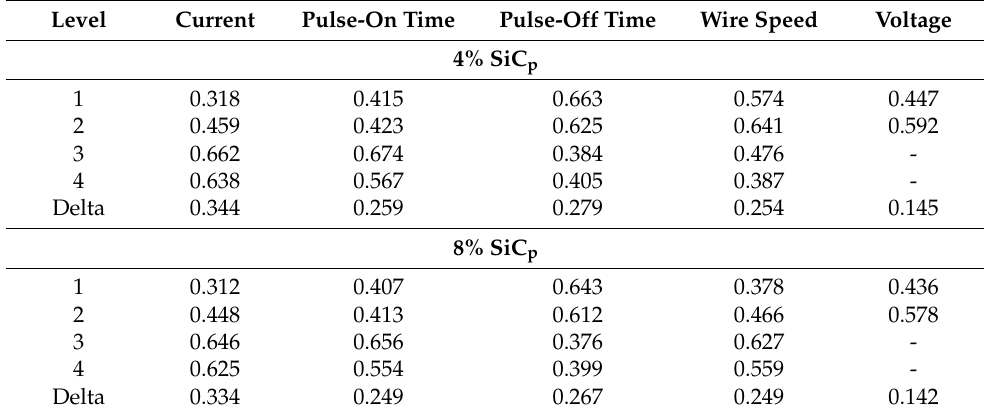
Table 5. The average MRR.